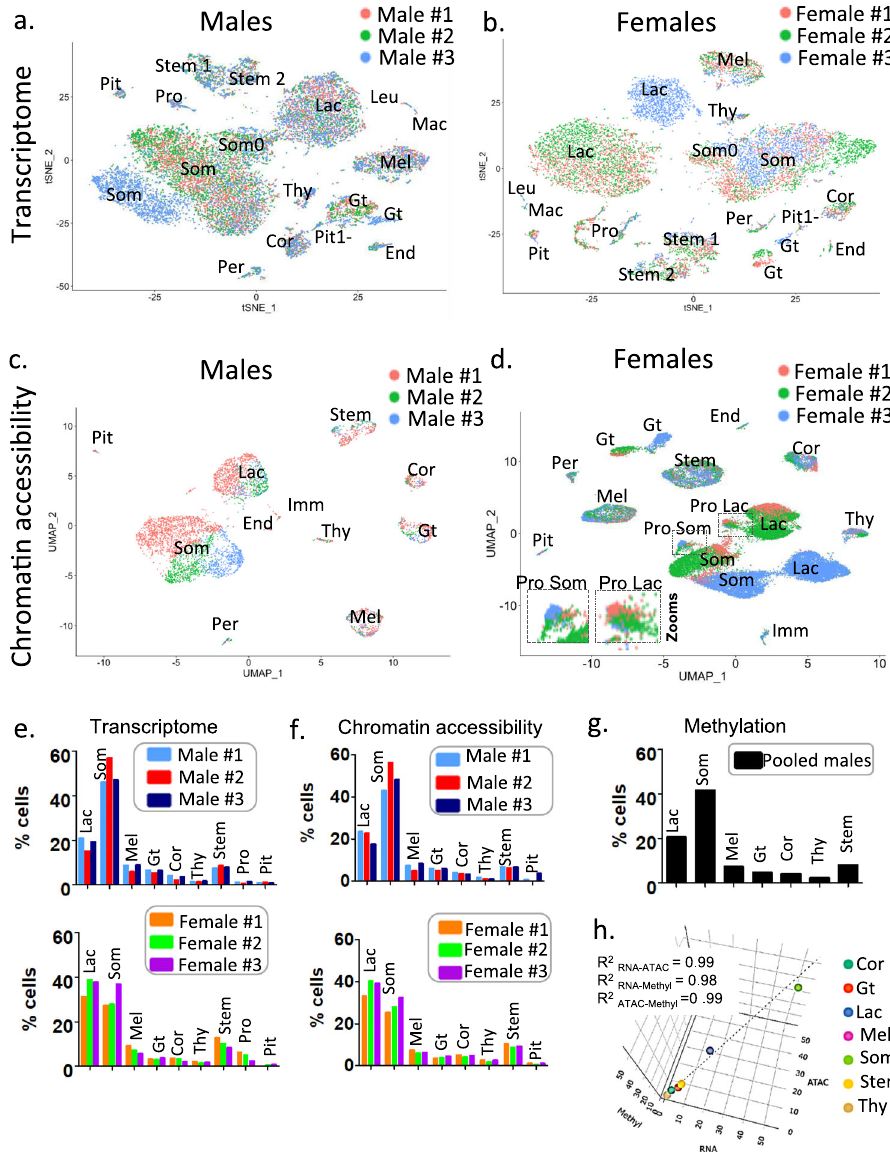
Fig. 4 Male – female differences in cell types. a – d t-SNE representation of sn transcript expression ( a , males; b , females) and of sn chromatin accessibility ( c , males; d , females) in merged same-sex samples, with labeling by individual animal. Individual animals are color-coded as indicated. Each cluster is identi fi ed by a letter code. The code for each cell type is presented at the bottom of Fig.2. In panel d , magni fi cations of the proliferative somatotrope and proliferative lactotrope clusters are shown as inserts. Refer to Fig.2a,b (males) and Supplementary Fig. 2a,b (females) for the merged analyses. e, f Cell type proportions per animal identi fi ed from the snRNAseq ( a, b ) and snATACseq ( c, d ) datasets show individual differences that are concordant (see also Supplementary Table 2). Male – female differences are signi fi cant for lactotropes and somatotropes ( p < 0.0001) in both assays. N = 6 independent animals were examined (3 males, 3 females), with the following number of nuclei per assay and per animal: (i) for snRNAseq: male #1, 7,150; male #2, 4,562; male #3, 6,146; female #1, 6,717; female #2, 5,282; female #3, 4,186; (ii) for snATACseq: male #1, 2,782; male #2, 880; male #3, 1,095; female #1, 4,847; female #2, 9,976; female #3, 11,832. Data are presented per individual animal, with a single column for each. For the assessment of sex difference in cell type proportions, we used a two-way analysis of variance (ANOVA) followed by Bonferroni multiple comparisons post-hoc test, with n = 3 biological replicates per cell type. g Cell type proportions identi fi ed in snMethyl data from pooled male pituitaries. A pool of 30 animals was used with 2,756 nuclei analyzed. h 3D correlation plot between gene expression, chromatin accessibility, and snMethyl for the identi fi cation of cell type proportions in male